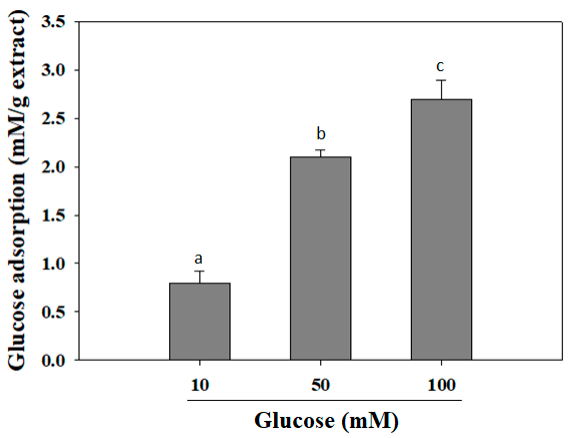
Figure 2. Glucose adsorption capacity of M. indica leaf extract. The extract was added to glucose solution and mixed well for 6 h. The mixture was then centrifuged and glucose content in the supernatant was determined. Each determination was made in three independent experiments, and the data are shown as means ± SD. Different letters a–c indicate significant difference among groups ( p < 0.05) by Duncan’s multiple-range test.